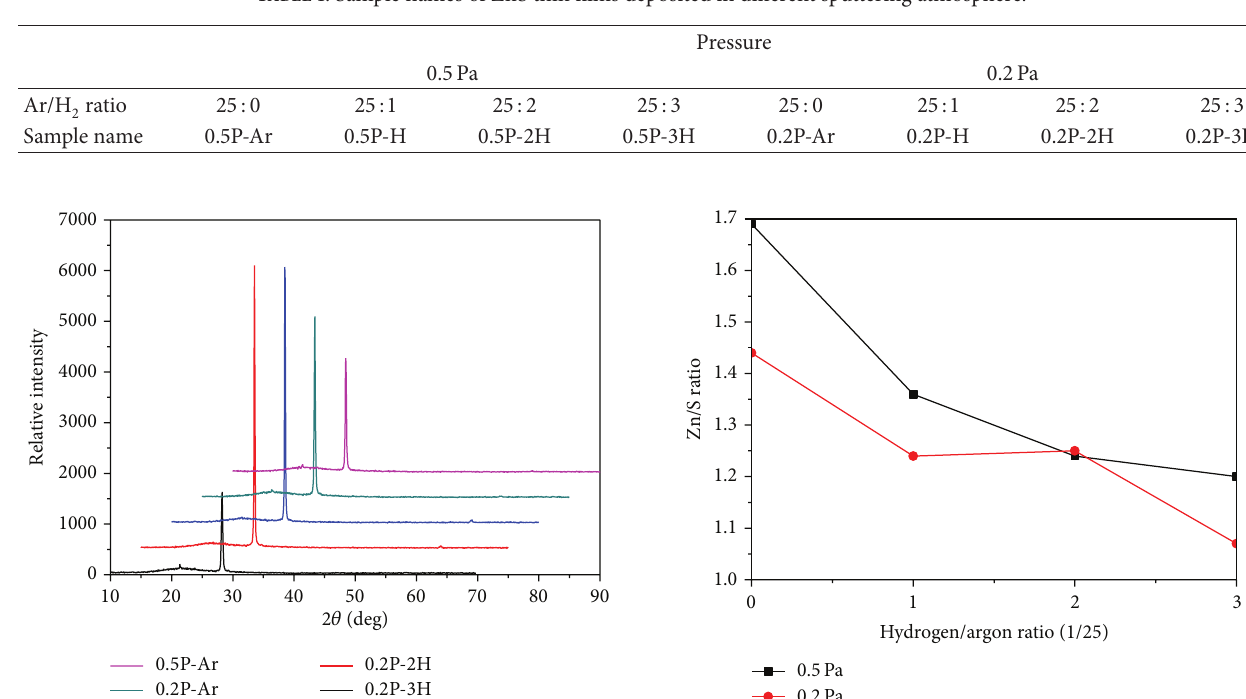
Figure 2: XRD patterns of ZnS films grown at various atmospheres.